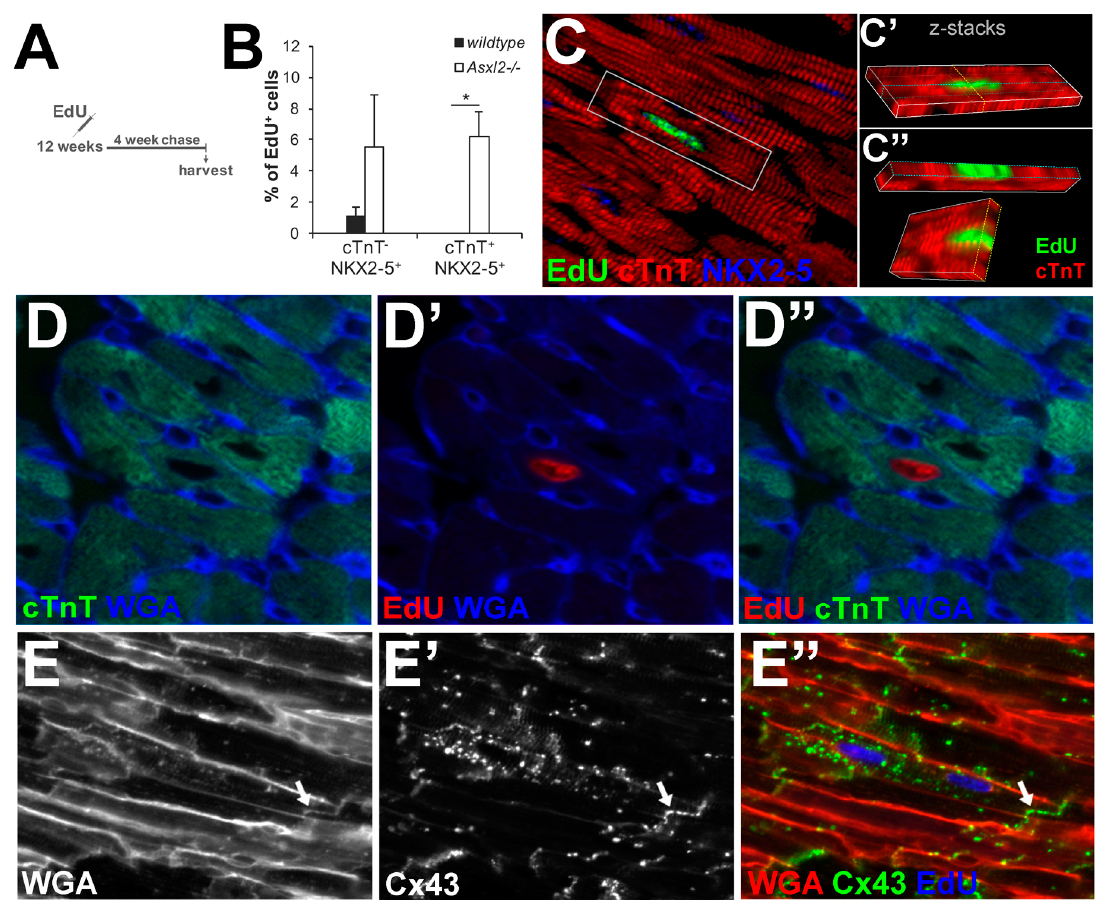
Figure 5. EdU-labeled cells give rise to cardiomyocytes in Asxl2 − / − hearts after 4-week chase. ( A ) Schematic of the lineage tracing assay used to assess the differentiation potential of the proliferating non-cardiomyocytes observed at 12 weeks of age; ( B ) Quantification of the percentage of EdU + cells that are cTnT − NKX2-5 + and cTnT + NKX2-5 + in the left ventricle following the chase; ( C ) Representative image of a mononuclear, EdU + cTnT + NKX2-5 + cell in a longitudinal orientation; ( C’ ) The same cell in c, shown in a z-stack image; ( C’’ ) Cross-sections of the z-stack image in c’; ( D – D” ) Representative image of an EdU + cTnT + cell, delineated with wheat germ agglutinin (WGA), in a transverse heart section; ( E – E” ) Representative image of EdU, WGA and labeling for the gap junction protein, connexin 43 (CX43). The arrow indicates the CX43 + membrane between two cardiomyocytes. Sample size: n = 3 animals per genotype; three non-consecutive sections/heart; analyzed LV from whole section-stitched images; 617 and 755 EdU + cells were examined on wildtype and Asxl2 − / − heart sections, respectively. Bars represent standard deviation. * p- Value (Student’s t -test) < 0.05.